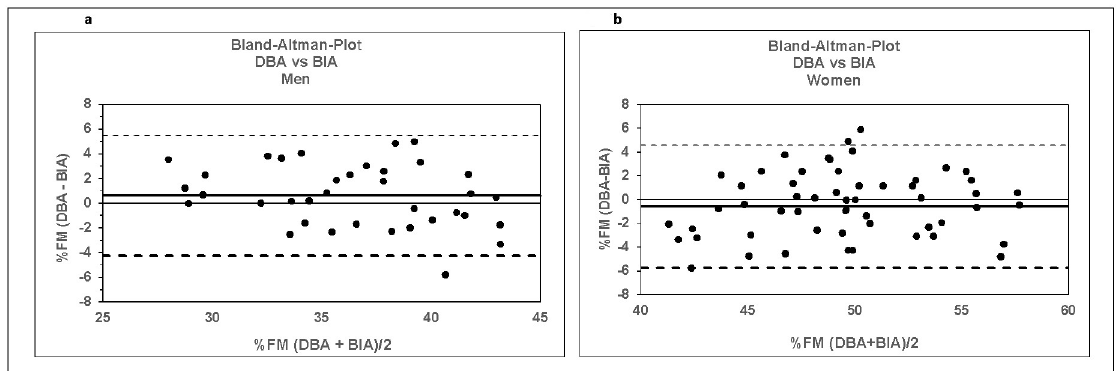
Fig 3. a and b: Bland-Altman plot for men (Fig 3a) and women (Fig 3b) showing limits of agreement between the values of %FM estimated by DBA system vs. those derived from BIA measurements. Bold continuous lines indicate the observed average agreement. Continuous lines indicate the line of perfect average agreement. Dashed lines indicate 95% limits of